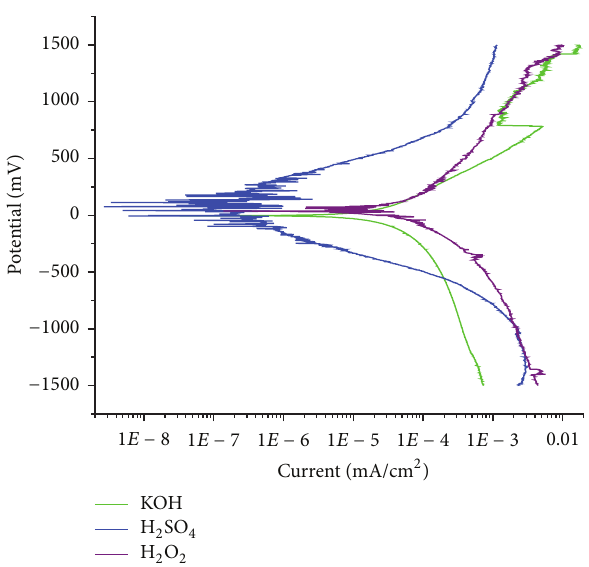
Figure 8: Polarization curve for electrospun Ny/FGO coating under acid, neutral, and basic solutions.